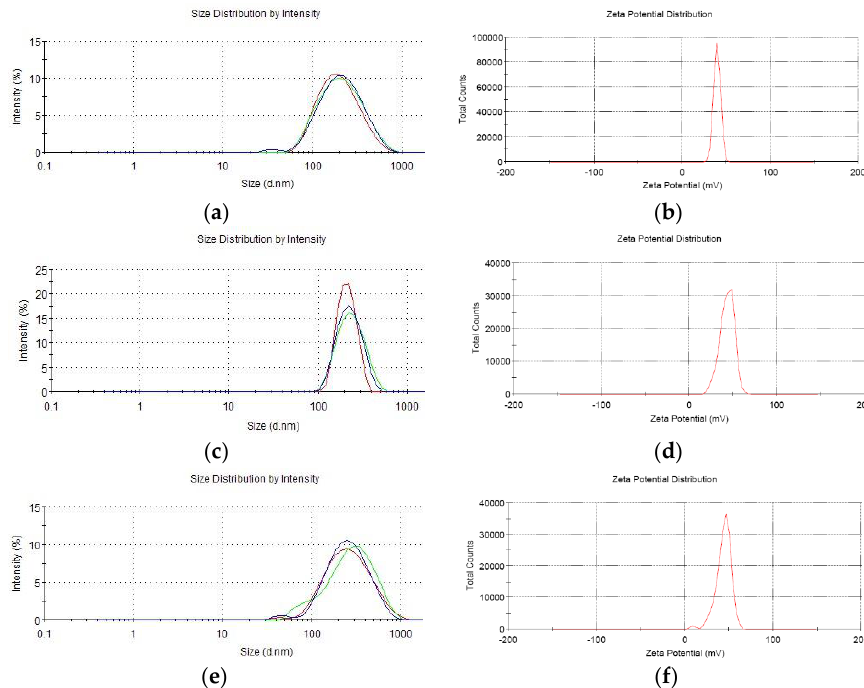
Figure 2. The parameters of average granule diameters and Zeta potentials of chitosan nanoparticles. ( a , c , e ) The average granule diameters of CS-VAP, CS-VAP4/6, and CS-pVAX1, respectively; Each color represents one test. ( b , d , f ) The Zeta potentials of CS-VAP, CS-VAP4/6, and CS-pVAX1, respectively.